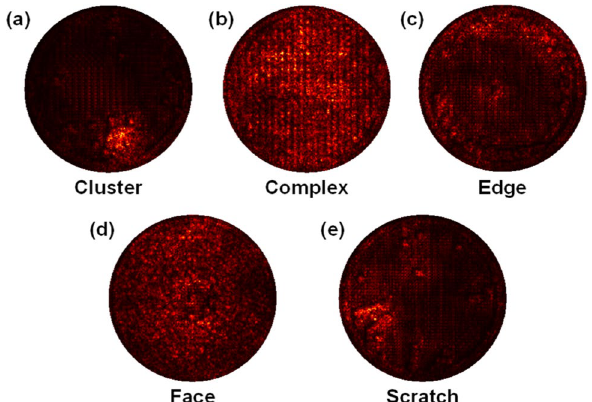
Figure 6. Saliency maps of 5 defect classes: ( a ) Cluster, ( b ) Complex, ( c ) Edge, ( d ) Face, and ( e ) Scratch.